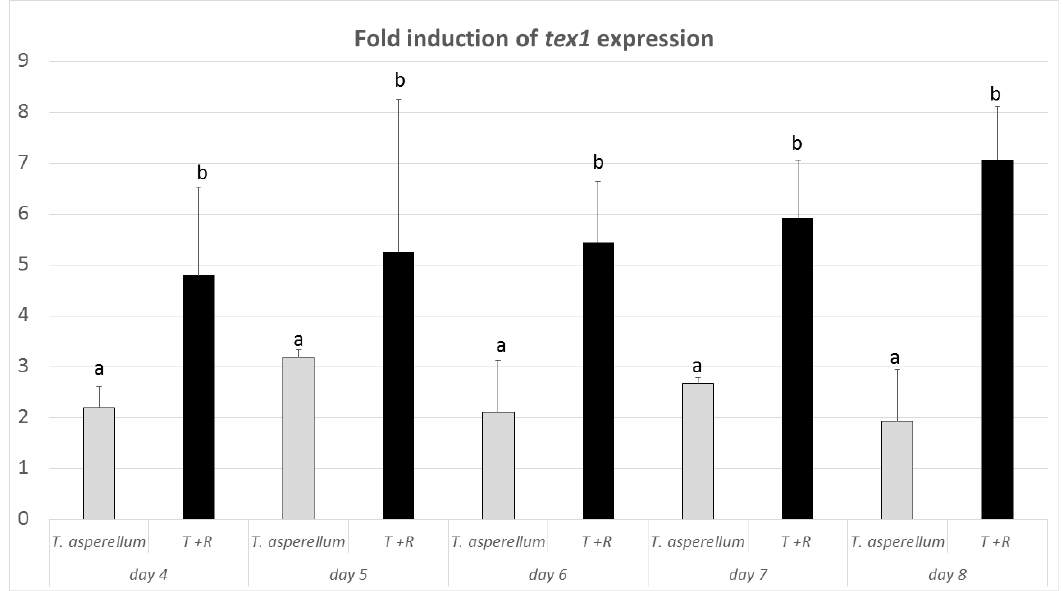
Figure 10. Quantitative RT-PCR analysis of tex1 . Values (2 −ΔΔ CT ) correspond to relative measurements against the tex1 transcript in Trichoderma asperellum IRAN 3062C (T) and T. asperellum IRAN 3062C challenged with Rhizoctonia solani (T + R). β -tubulin was used as an internal reference gene. Bars represent standard deviations of the mean values of three biological replicates. Different letters (a and b) indicate significantly different values ( p < 0.05).